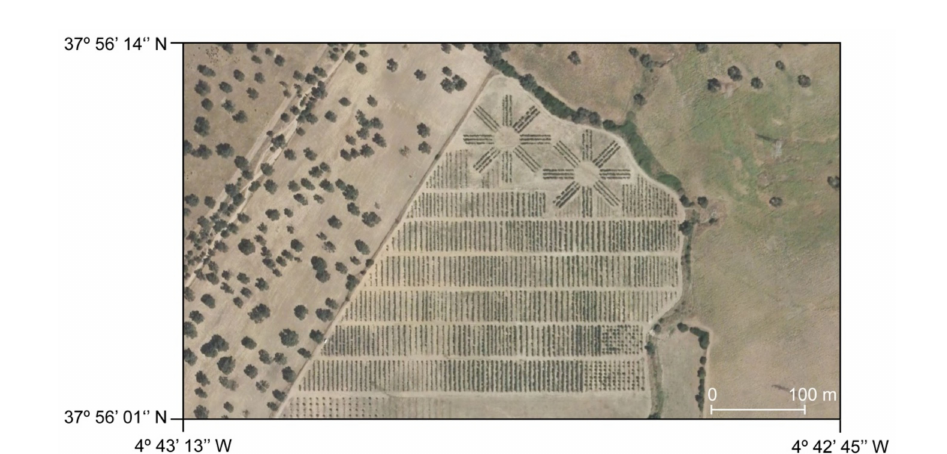
Figure 4. Location of the “nature